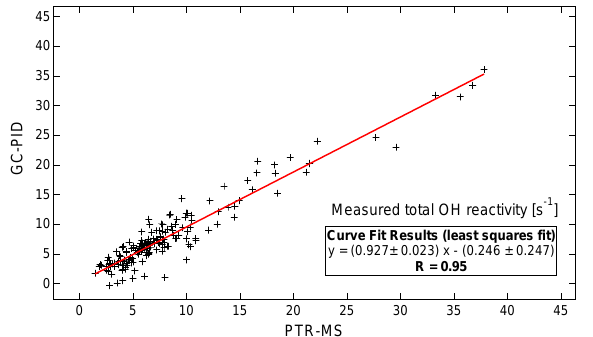
Fig. 11. Correlation of PTR-MS and GC-PID results (15min aver- ages) for total OH reactivity measured from boreal tree species in the JPAC plant chamber. A linear least squares curve fit, its slope and the quality of the correlation (Pearson R) are